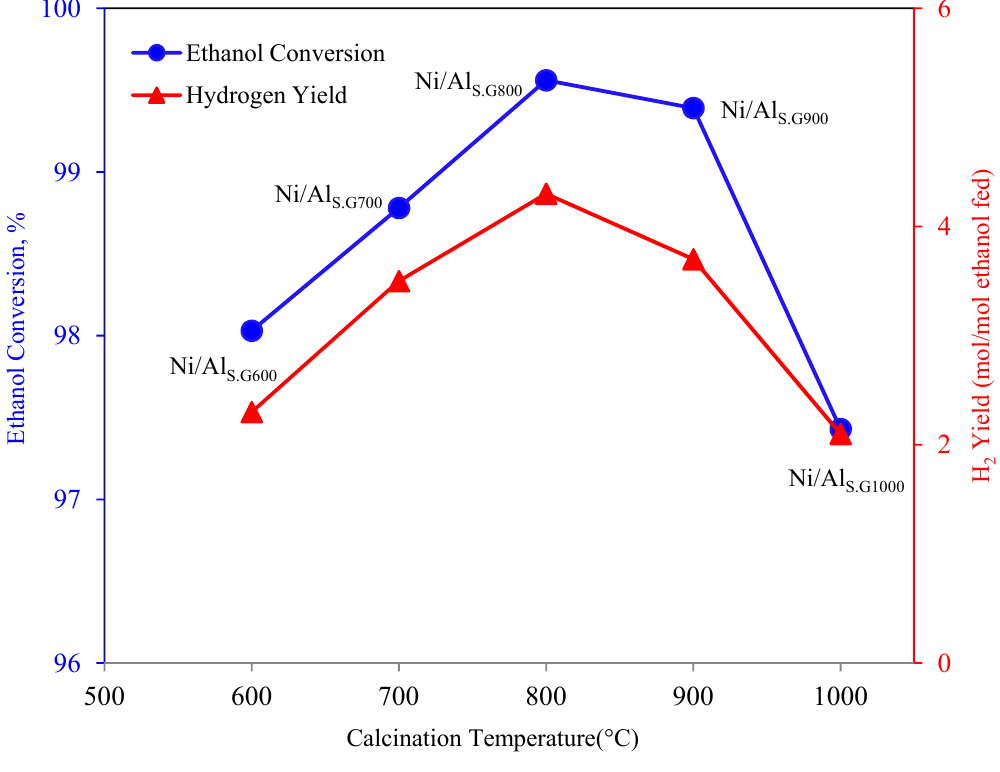
Figure 4. Ethanol conversion and hydrogen yield over Ni/sol gel made alumina catalysts in the steam reforming of ethanol, plotted as a function of calcinations temperature of the support. The catalytic data were obtained after 8 h reaction.